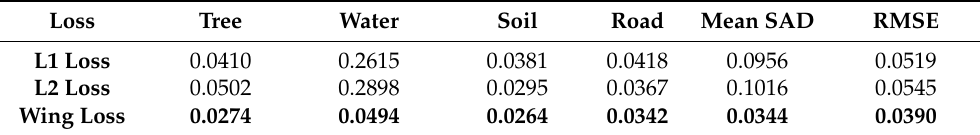
Table 6. Comparison of different loss functions used by the proposed network in Jasper Ridge Dataset. The best results are shown in bold.